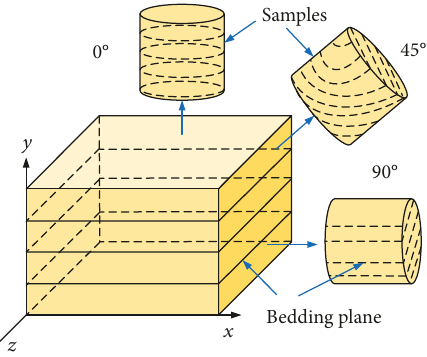
Figure 7: The three-plug method schematic.